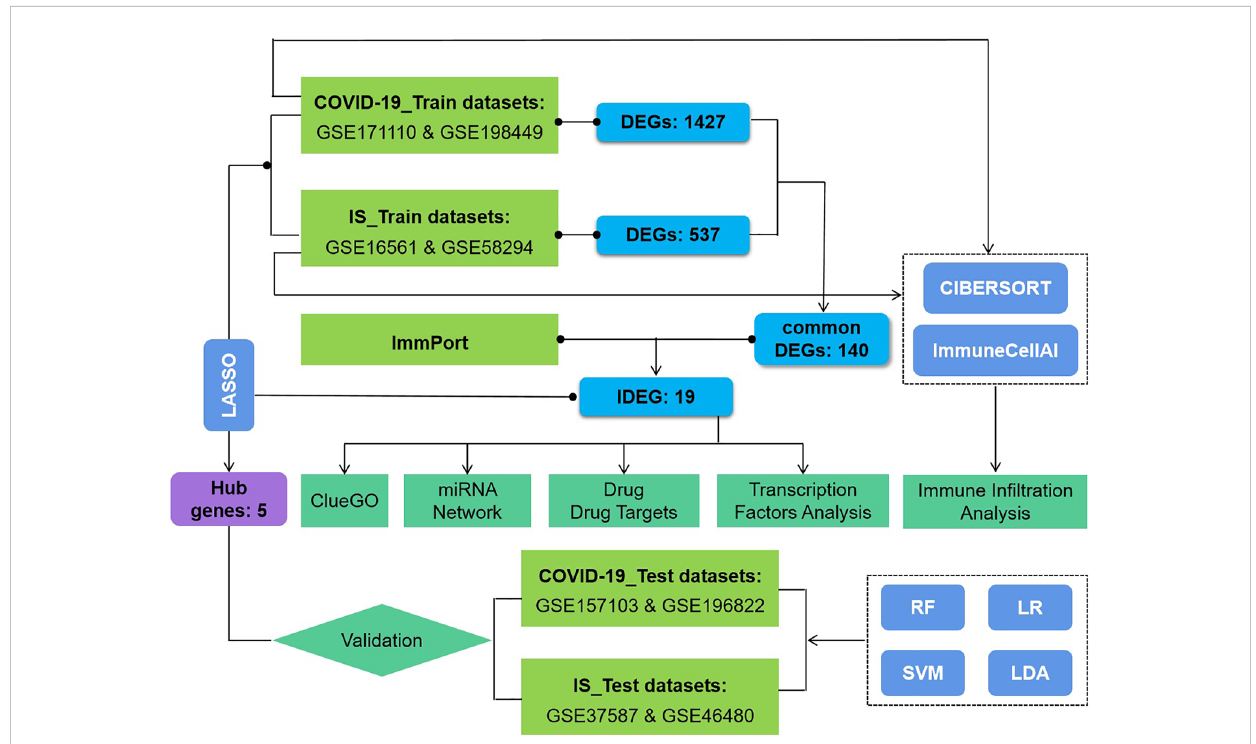
FIGURE 1 Flowchart of the study. Expression pro fi le data from whole peripheral blood of patients with COVID-19 or ischemic stroke (IS) were obtained, and differential gene expression was performed between patients and healthy controls. ClueGO, drug targets, miRNA network, transcription factors and immune in fi ltration analysis were applied to common IDEGs between COVID and IS to explore shared mechanism between these two diseases. Hub genes obtained by LASSO regression were validated with test dataset of COVID and IS, using four machine learning methods. RF, Random Forest; SVM, Support Vector Machine; LR, Logistic Regression; LDA, Linear Discrimination Analysis. 108 IS patients and 47 matched controls as well as 281 COVID patients and 414 matched controls were employed to perform differential